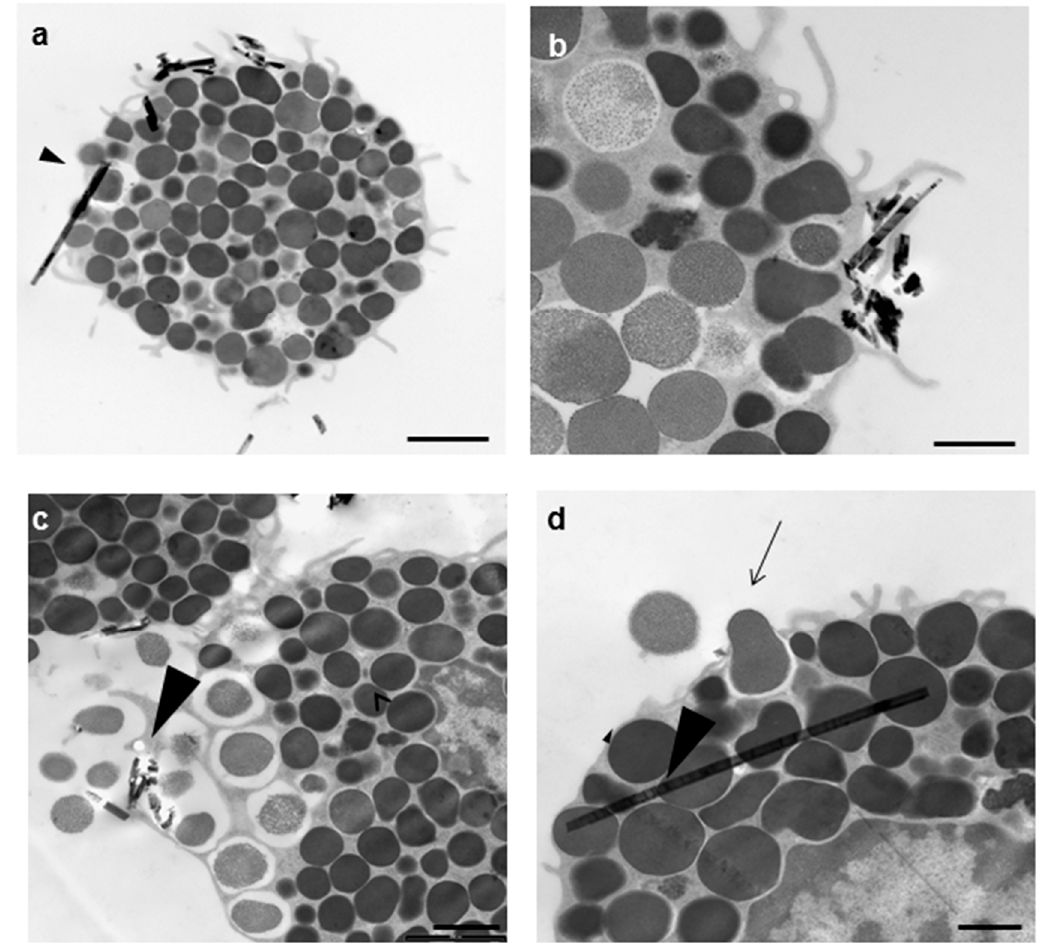
Figure 4. Transmission electron microscopy appearance of an RPMC exposed to 100 µ g/mL of crocidolite fibers. After 30 min of incubation, the interacting fibers appear to undergo ingestion ( a , b ) or are free in the cytosol (arrowhead in ( a , d )); ( c ) a degranulation process is evident where asbestos fibers are present; ( d ) the RPMC releasing a single granule (arrow). Magnifications: bar in ( a ) = 2 µ m; bar in ( b ) = 1 µ m; ( c ) = 2 µ m; ( d ) = 0.5 µ